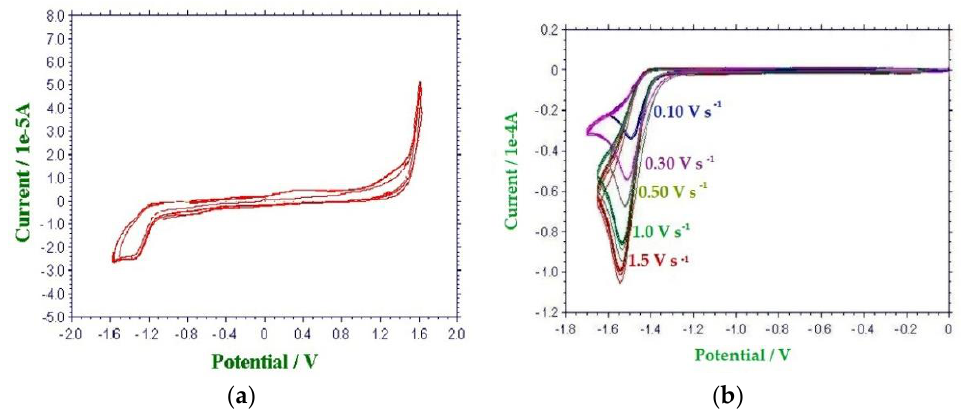
Figure 2. CV responses of HMF (1 mmol dm −3 ) in a 0.1 mol dm −3 water solution of supporting elec-